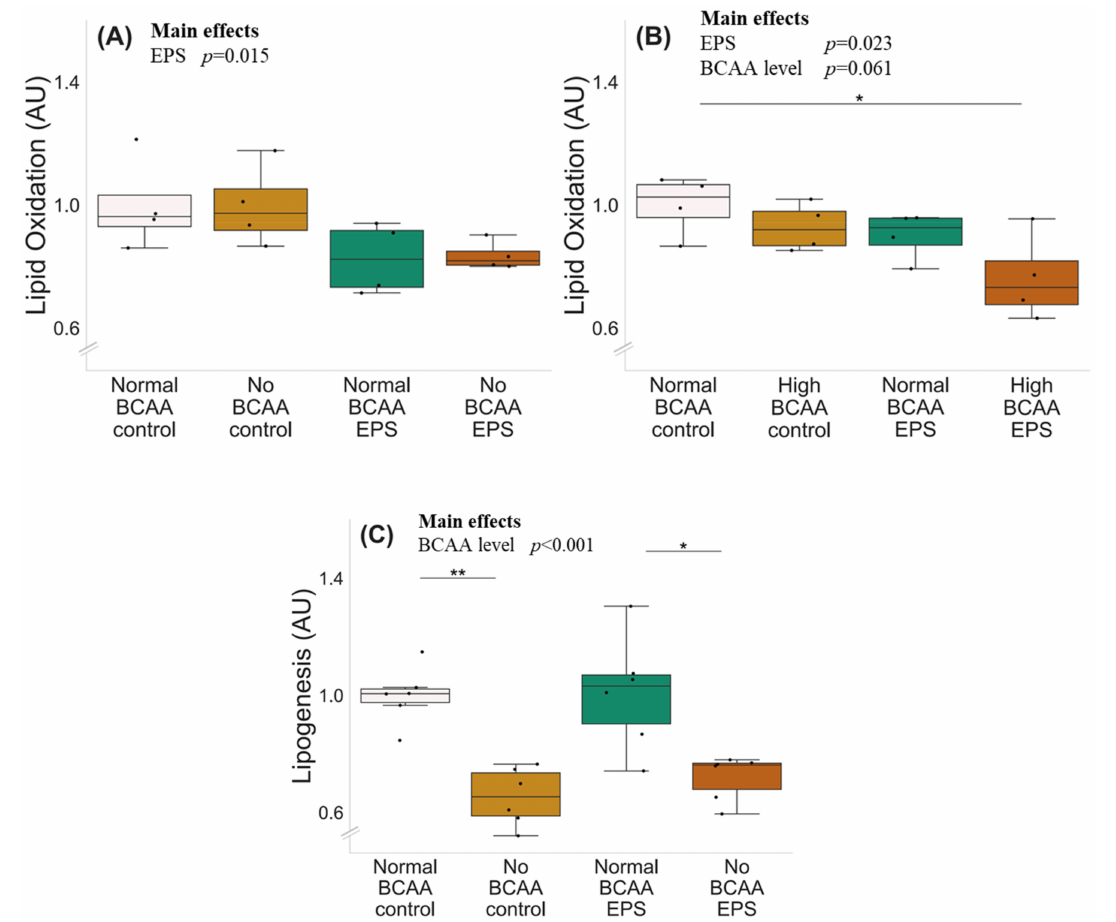
Figure 4. Lipid oxidation, BCAA deprivation and EPS in murine C2C12 myotubes with normal ( A ) and high ( B ) BCAA levels and lipogenesis with BCAA deprivation and EPS in myotubes ( C ). ( A ) Normal BCAA (0.8 mmol/L) concentration, EPS or BCAA deprivation did not affect lipid oxidation. ( B ) High BCAA (2.8 mmol/L) combined with EPS-reduced lipid oxidation. n = 4/group. ( C ) Deprivation of BCAAs reduced lipogenesis in myotubes during control conditions (normal BCAA vs. no BCAA) and with EPS treatment (normal BCAA EPS vs. no BCAA EPS) n = 6/group. Boxes